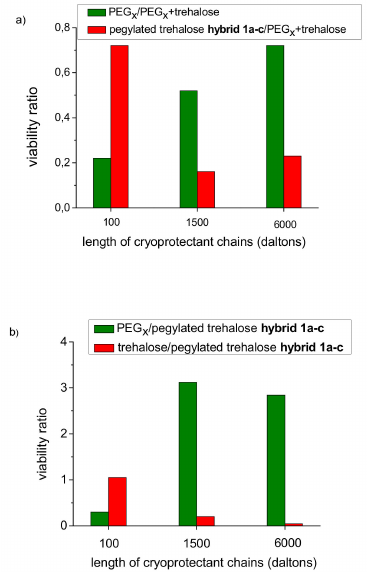
Figure 3. Determination of viability at comparable stoichiometric concentration of cryoprotectants: ( a ) Viability ratio of PEG x (green) and 1a – c (red) treated frozen / thawed cells related to viability of cells treated by a mixture of PEG x / trehalose; the efficiency of cryoprotectivity for 1a – c was observed as a potential result of the fact that short pegylated linkage of 1a prevents a high destabilization of cell membrane; approaching of middle PEG-chains to cell membrane increases the probability for stronger interactions with water resulting in the destabilization of membrane ( b ) Viability ratio of PEG x (green) and trehalose (red) treated frozen / thawed cells related to viability of cells treated by pegylated hybrids 1a – c